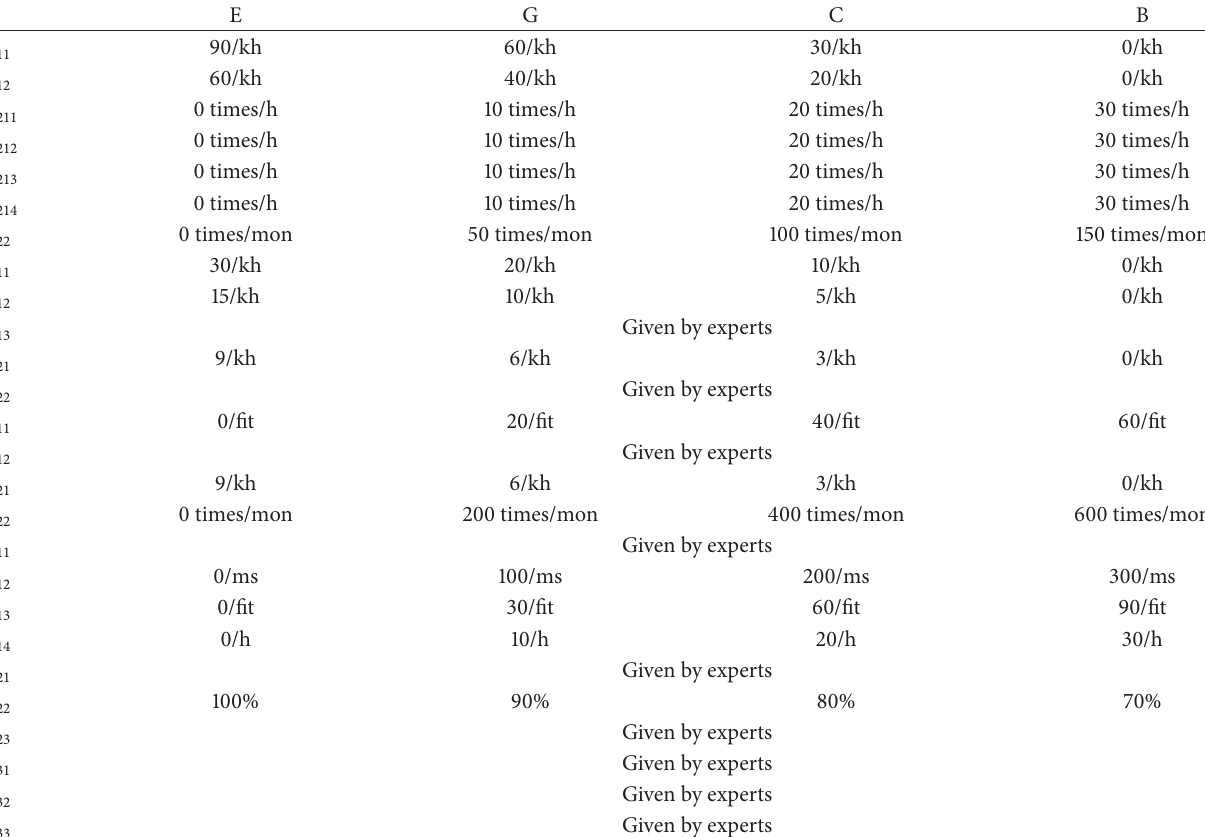
Table 2: The reference values of the assessment